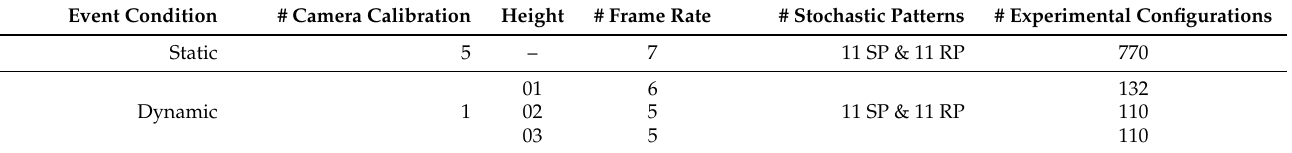
Table 2. Experimental configurations (or data sets) tested under static and dynamic event